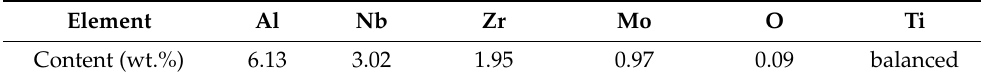
Table 1. The chemical composition of the Ti-6Al-3Nb-2Zr-1Mo (Ti-6321) alloy. Element Al Nb Zr Mo O Ti Content (wt.%) 6.13 3.02 1.95 0.97 0.09 balanced